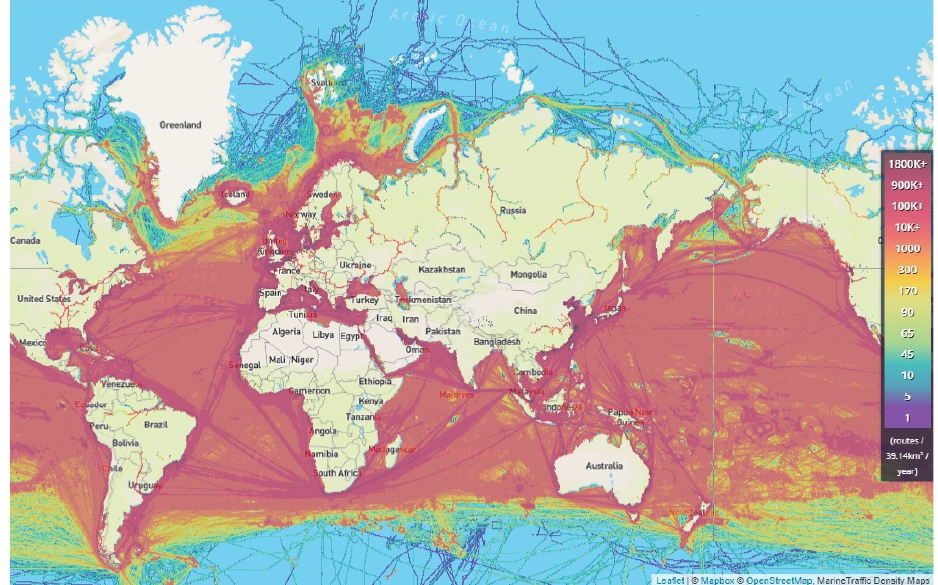
Figure 5. Worldwide marine traffic in 2021, generated from: Marine Traffic [6].